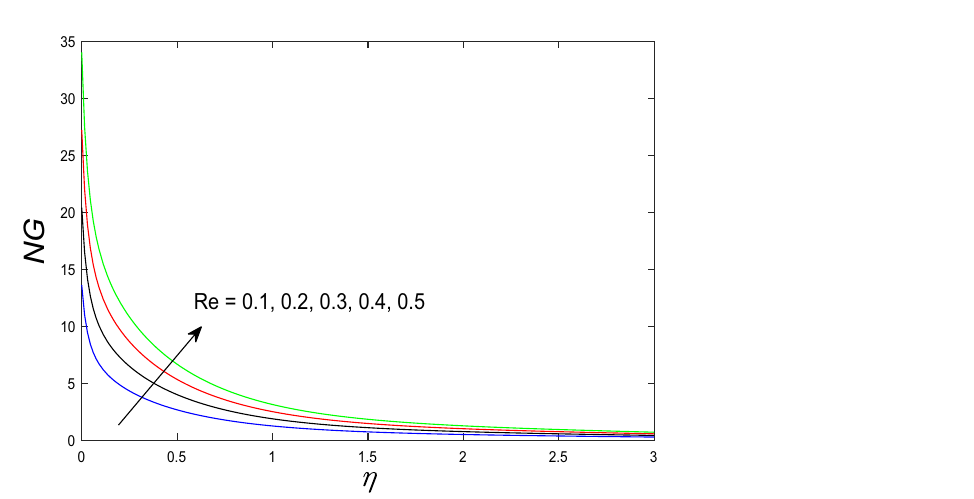
Figure 22. Plot of N G for Re .